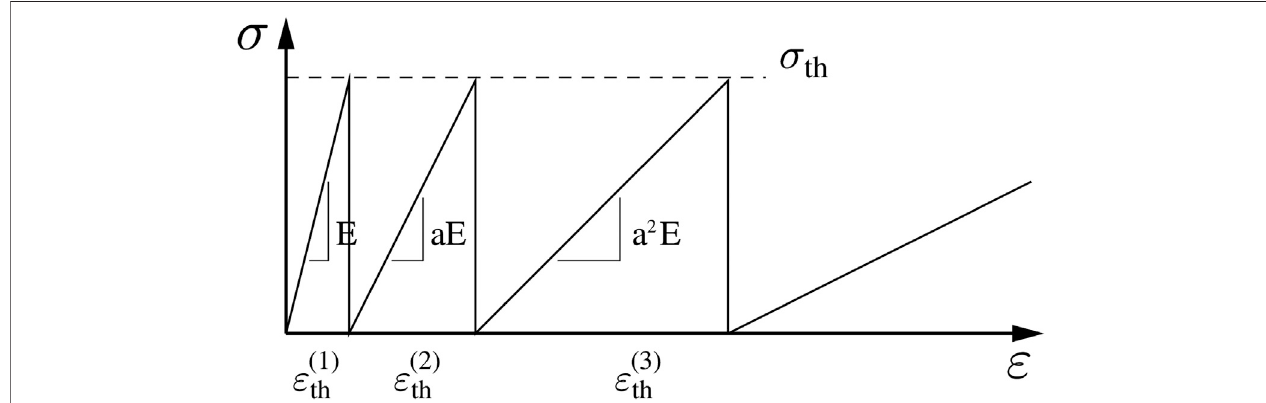
FIGURE1| Mechanicalresponse ofasingle fi berinthecaseofquencheddisorderwhentheslippingthreshold σ th is fi xedfortheentiredamagehistoryofthe fi ber. The value of a is set to a (cid:1) 0 . 8 so that gradual stiffness degradation occurs through the subsequent stick-slip periods. Since the stiffness is changing, the threshold strains of slipping are increasing ε ( 1 ) th < ε ( 2 ) th < ε ( 3 ) th , in spite of the fi xed stress threshold σ th of the fi